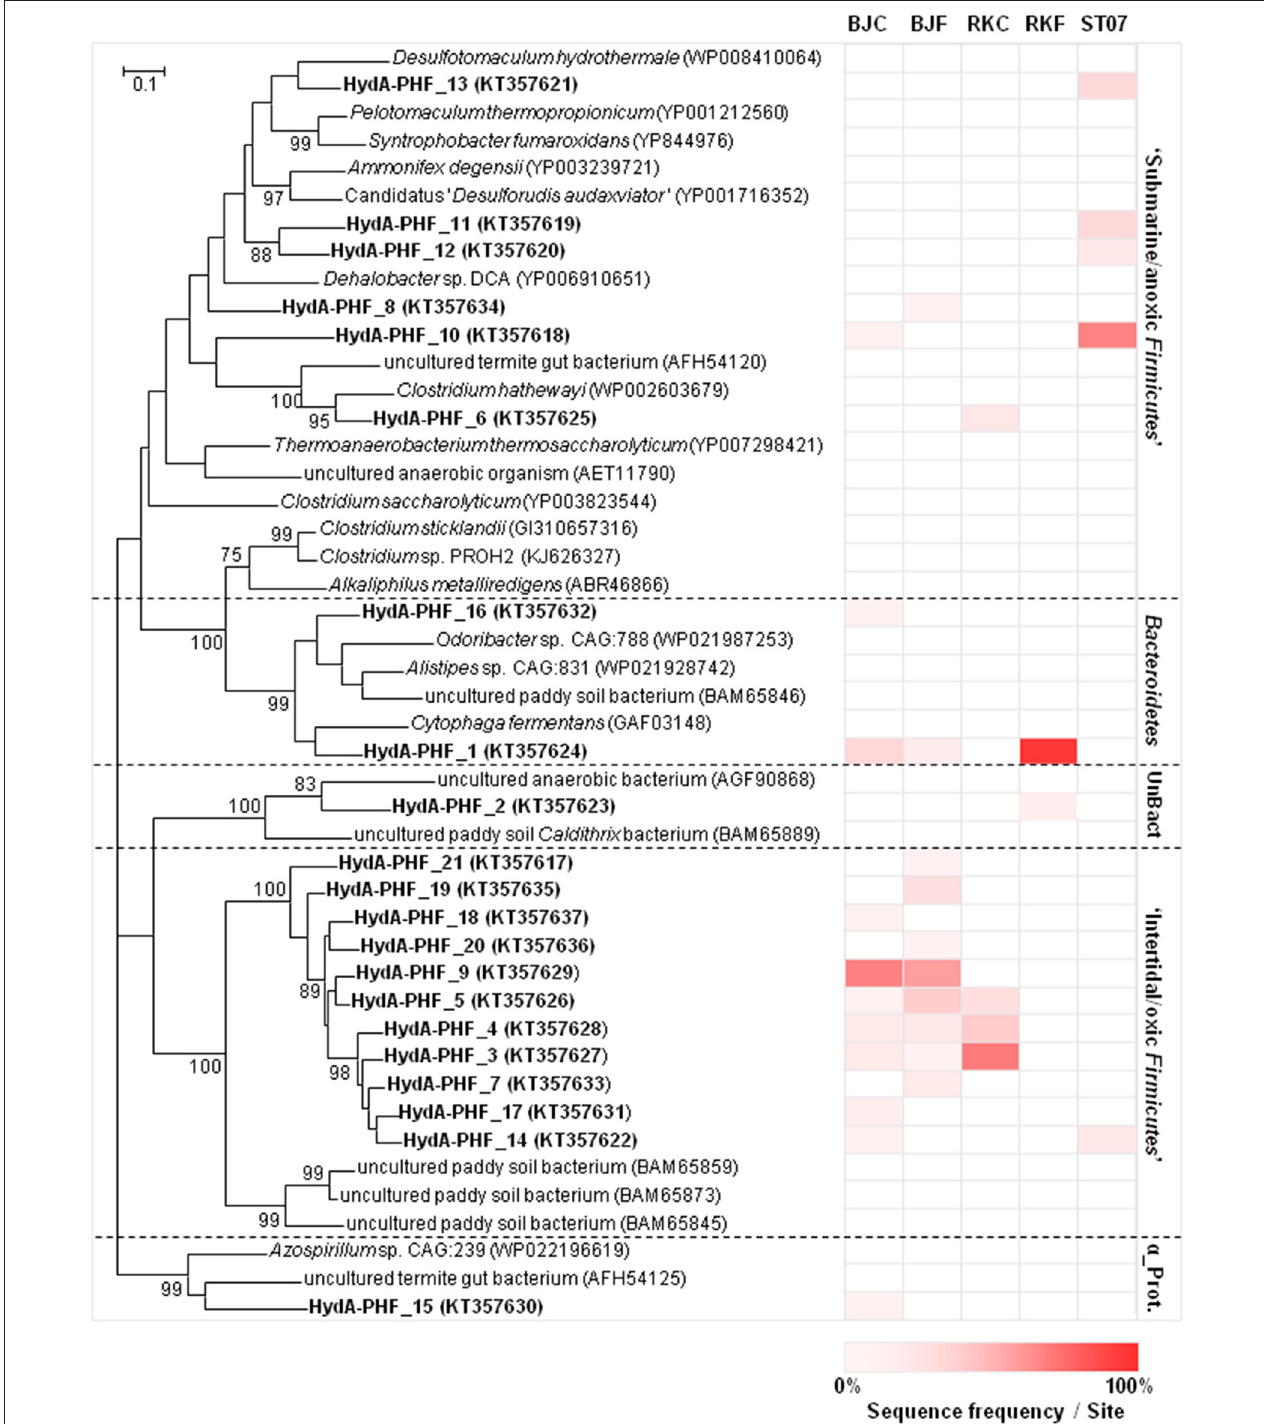
FIGURE 4 | Maximum-likelihood phylogenetic tree of [Fe-Fe]-hydrogenase sequences obtained from intertidal and submarine PHF sites. Protein HydA sequences (188 amino acids) were obtained after translation of hydA gene sequences (obtained by cloning and Sanger sequencing) for 3 PHF hydrothermal sites: “Bain des Japonais” (BdJ), “Rivière des Kaoris” (RK), and “Aiguille de Prony” (ST07). The suffix “C” in sample names corresponds to “chimney” and the suffix “F” corresponds to “fluid”. The [FeFe]-hydrogenase sequences from PHF samples are marked in bold. Each OTU is represented by one representative sequence (at ≥ 80% similarity level). Percentage of OTU with respect to the total number of retrieved sequences in each PHF site is indicated by different levels of red from 0% (white) to 100% (red). Genbank accession numbers (in brackets) were obtained from the protein sequence database. Bootstrap values < 70% are not shown. The scale bar indicates 0.1% sequence divergence. UnBact and α _Prot stand for unclassified Bacteria and Alphaproteobacteria , respectively.